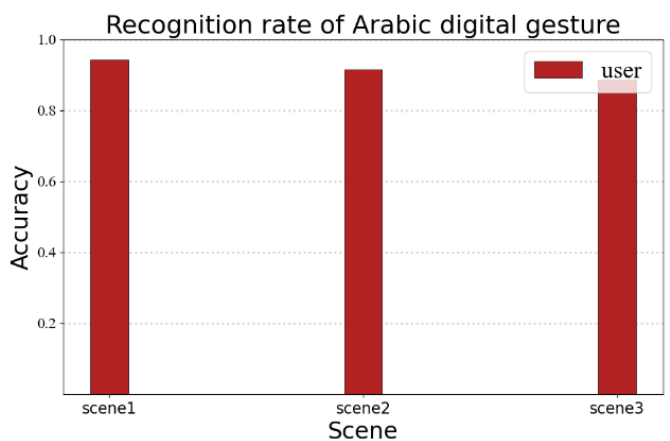
Figure 17. Accuracy in different environments.